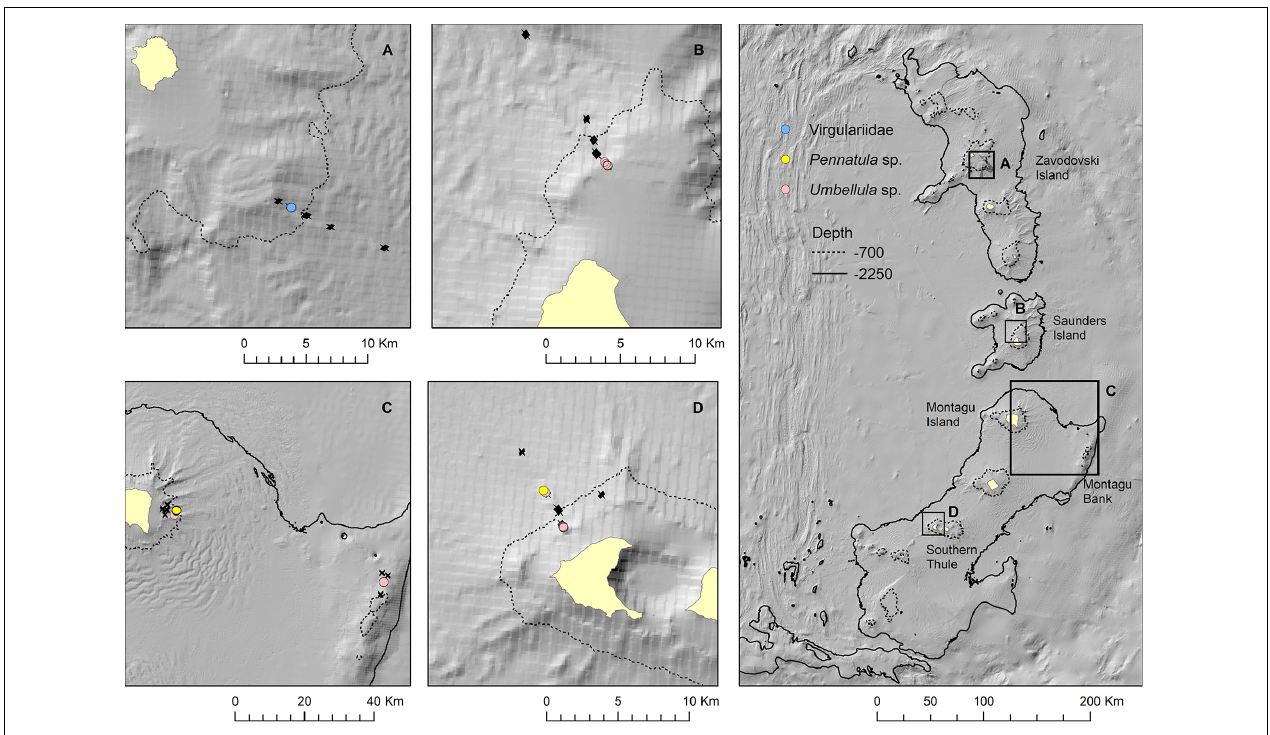
FIGURE 10 | Observations of sea pens in still images presented as point locations along drop camera transects at Zavodovski Island (A) , Saunders Island (B) , Montagu Island and Bank (C) , and Southern Thule (D) . Bathymetry from the South Sandwich Islands bathymetry compilation by Leat et al.